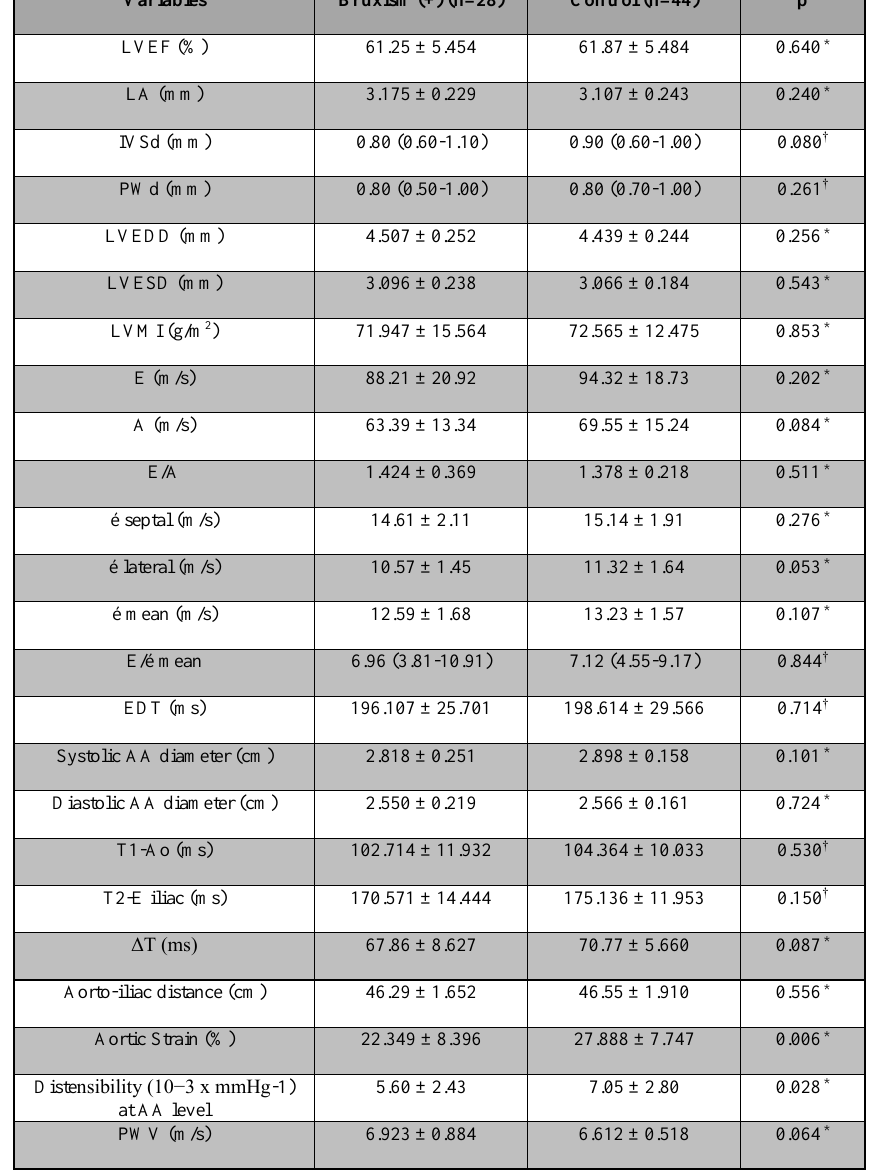
Table 2. Comparison of the echocardiographic and aortic stiffness parameters between Bruxism (+) and control subjects.